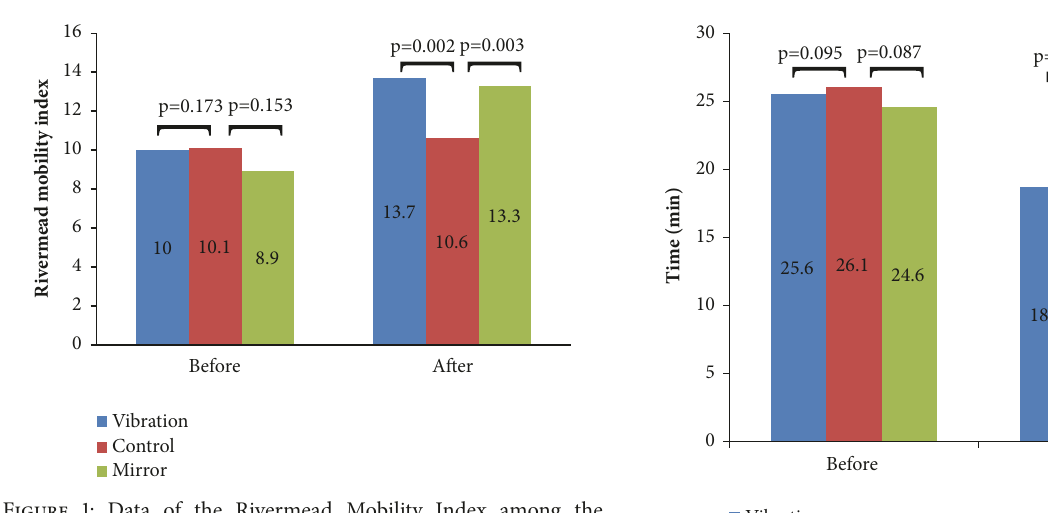
Figure 1: Data of the Rivermead Mobility Index among the individualsofthecontrolgroup,vibrationandmirrortherapybefore and after the interventions.